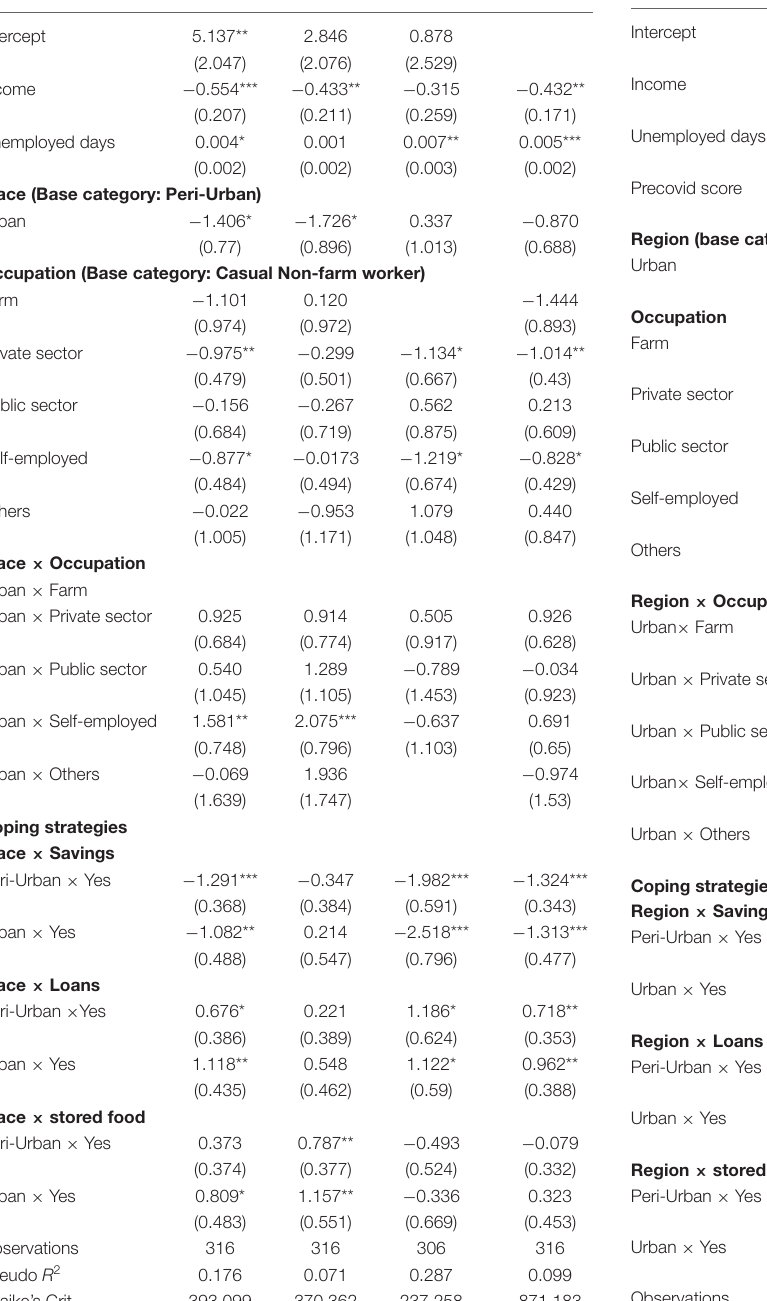
TABLE 3 | Determinants of household food insecurity in urban and pei-urban locations during the COVID-19 pandemic (March-November 2020).